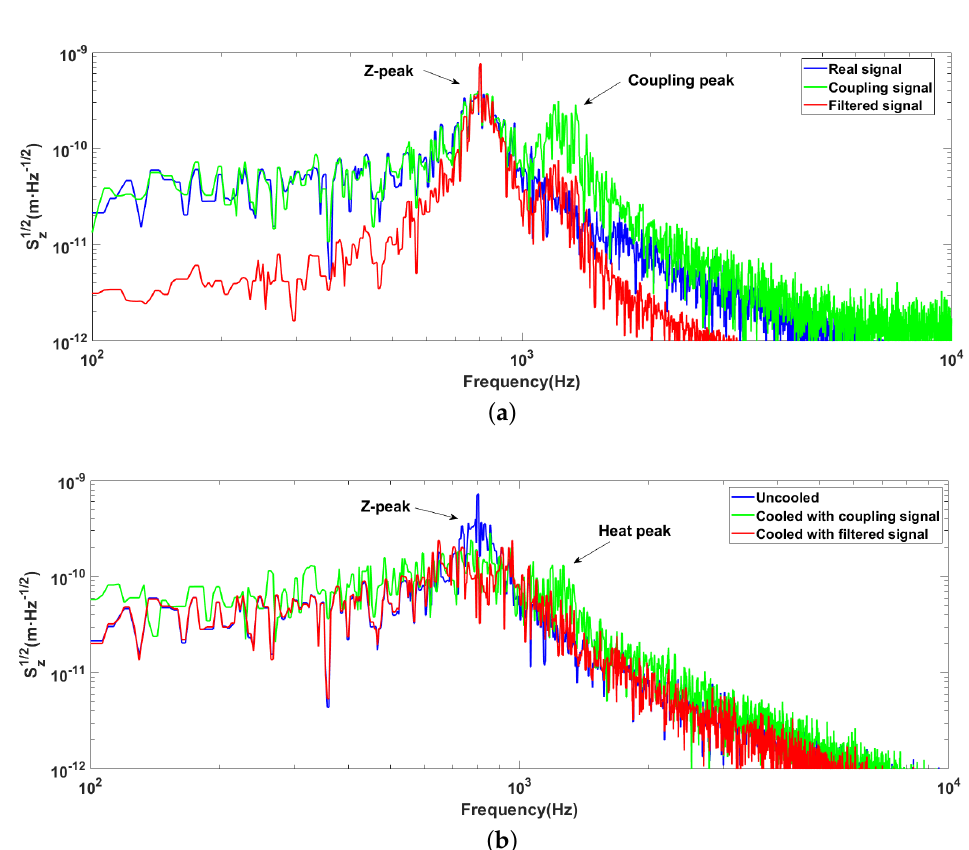
Figure 5. ( a ) The comparison of real signal, coupled signal and Kalman filtered signal. The ordinate represents the root of z -axis displacement power spectrum density of the particle. The blue line represents the real motion of the particle along the z -axis, the green line represents the z -axis detected signal mixed with the radial signal, and the red line represents the signal processed using the Kalman filter. The abscissa represents the frequency, and the ordinate represents the displacement power spectrum density. ( b ) The comparison of cooling performance using real signal, coupled signal and Kalman-filtered signal. The ordinate represents the root of z -axis displacement power spectrum density of the particle. The blue line represents the motion of the particle along the z -axis, the green line represents the particle motion in axial cooled using the coupled signal, and the red line represents the particle motion in axial cooled using the filtered